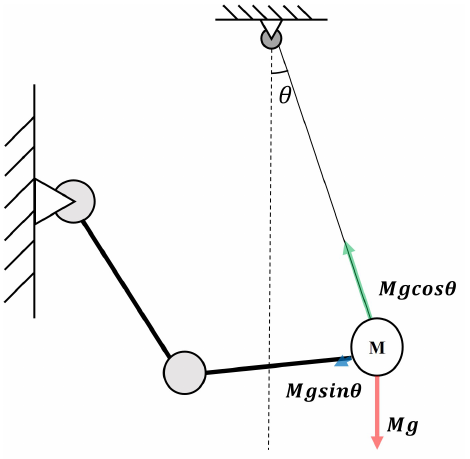
Figure 4. The restoring force that occurs when the end-effector is out of the pulley’s center